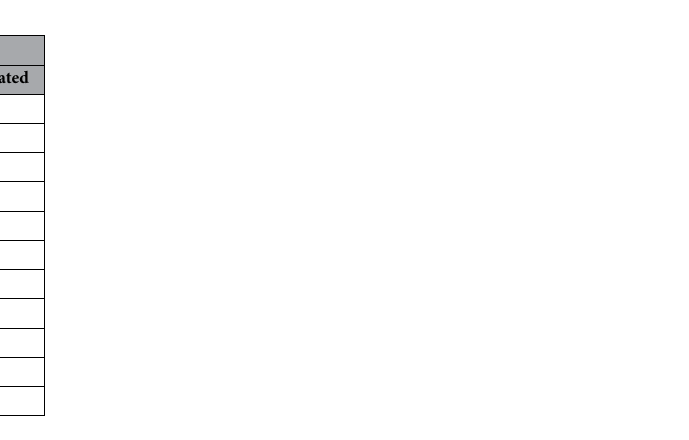
Table 2. Statistical indices of assessing the performance of APSIM-Wheat model in predicting grain